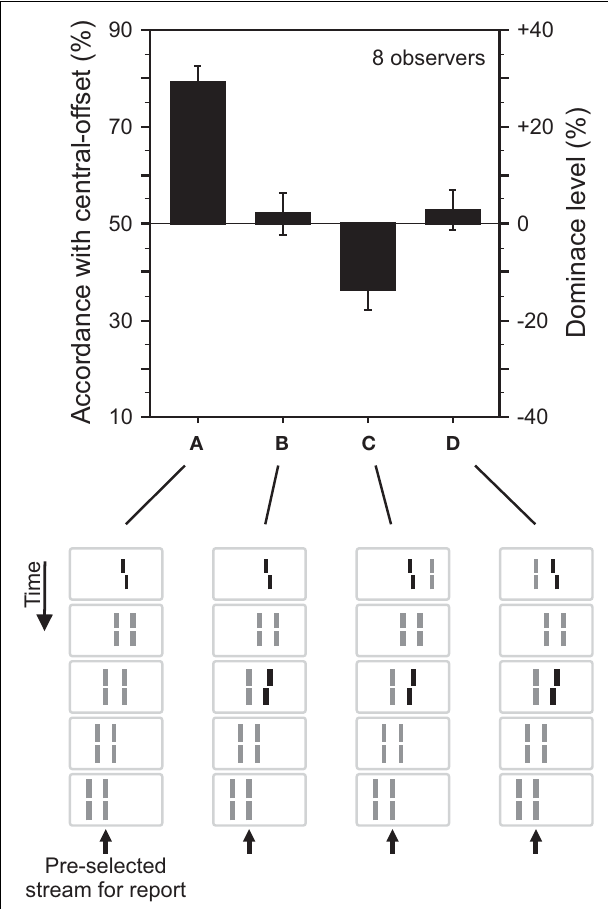
FIGURE 3 | Grouping based feature integration. (A) The central line was followed by two streams of lines shifting in parallel. Observers were asked to attend to the right motion stream.The offset of the central vernier is discriminated well. (B) Performance is changed when an additional offset is added to the second line of the right motion stream.These results are analogous to the experiment shown in Figure 2 . (C) The central line is flanked by an additional line on the right side. Performance is dominated by the additional offset (performance is below 50% because we determined responses in accordance with the central-offset and the second flank-offset was in the opposite direction.To ease intuition, this accordance level can be transformed into dominance level by subtracting 50%. As a result, the sign of the dominance level reflects dominance of the central- or flank-offset, respectively).We suggest that the additional line disambiguates the motion grouping, present in (A,B) , by assigning the “central” line to the left, unattended motion stream.The flank-offset in the right, attended stream determines performance. (D) The additional line is presented to the left of the central line, which elicits the percept of two bending motion streams. Performance is virtually not changed compared to (B) .We suggest that the additional line changes the motion percept (bend motion) but not the grouping of the “central” line to the right motion stream. Hence, central-offset and flank-offset are integrated. Copyright ©2006 ARVO. Adapted from Otto et al. (2006).